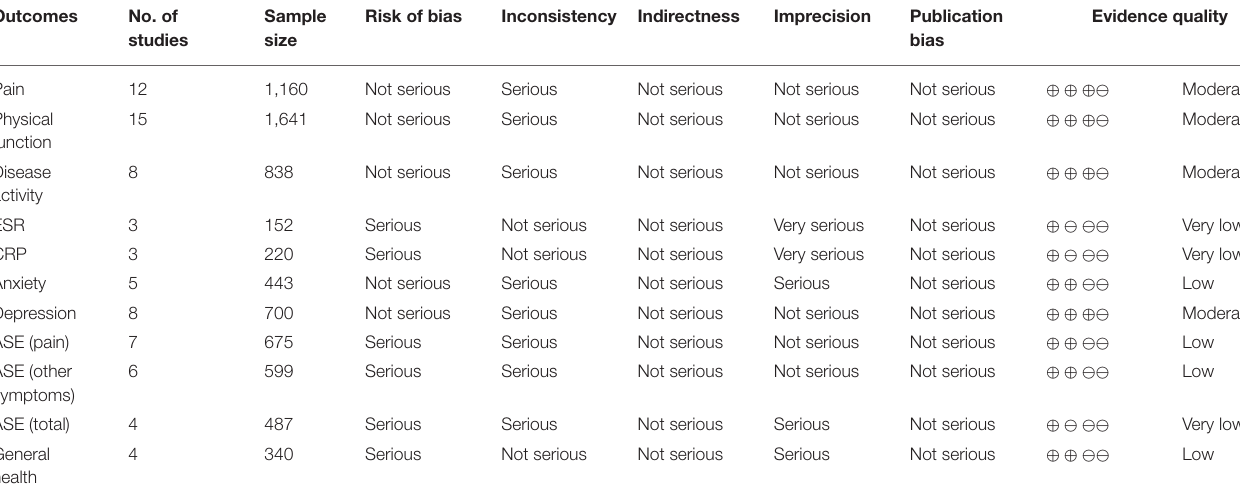
TABLE 3 | Evidence quality rated using the GRADE